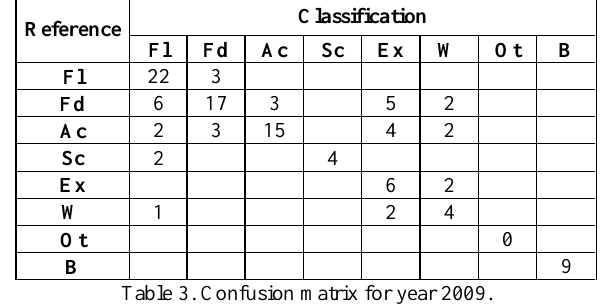
Table 3. Confusion matrix for year 2009.